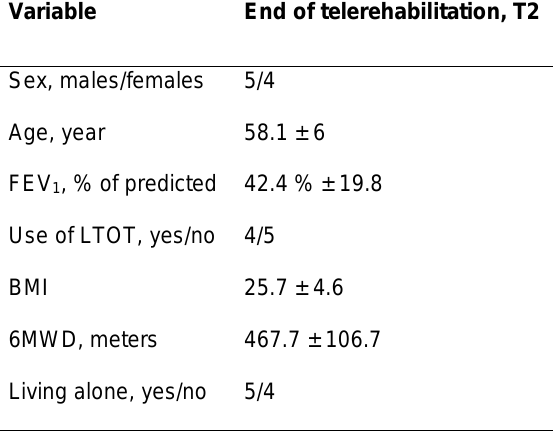
Table 2. Patients’ Characteristics at the End of the Telerehabilitation Intervention, T2